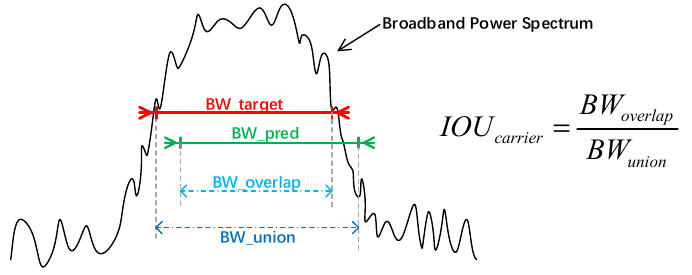
Figure 5. The carrier IoU.